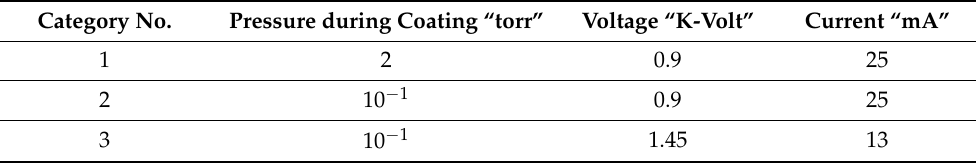
Table 1. Varying conditions for different categories of coatings. Category